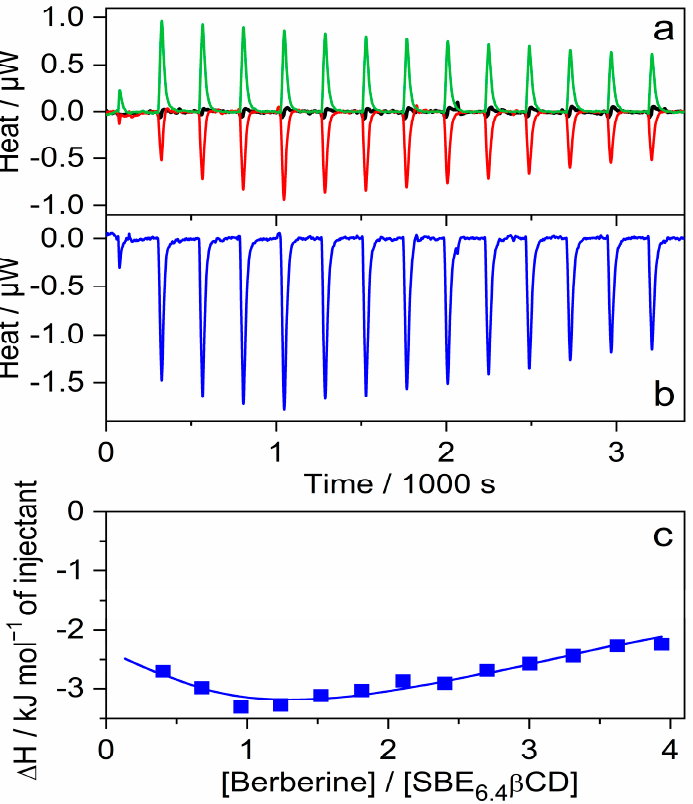
Figure 5. ( a ) ITC traces for the titration of 41 µ M SBE 6.4 β CD solution with water (black line) and 790 µ M B solution (red line). Absorbed heat upon the addition of 790 µ M B solution into water (green line); 20 µ L aliquots were injected into 1.433 mL volume. ( b ) Evolved heat after subtraction of the dilution heats of B and SBE 6.4 β CD. ( c ) The integral of the peaks displayed in panel ( b ) is divided by the mole of B as a function of [B]/[SBE 6.4 β CD] molar ratio. The line shows the best fit with a stepwise binding to two sites